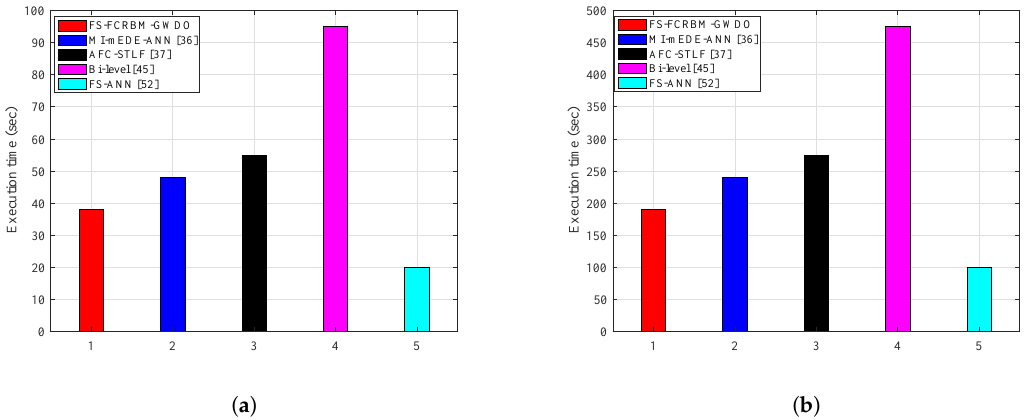
Figure 12. Execution time analysis of the proposed hybrid FS-FCRBM-GWDO model and benchmark models on FE power grid hourly load data. ( a ) Day ahead; ( b ) Week